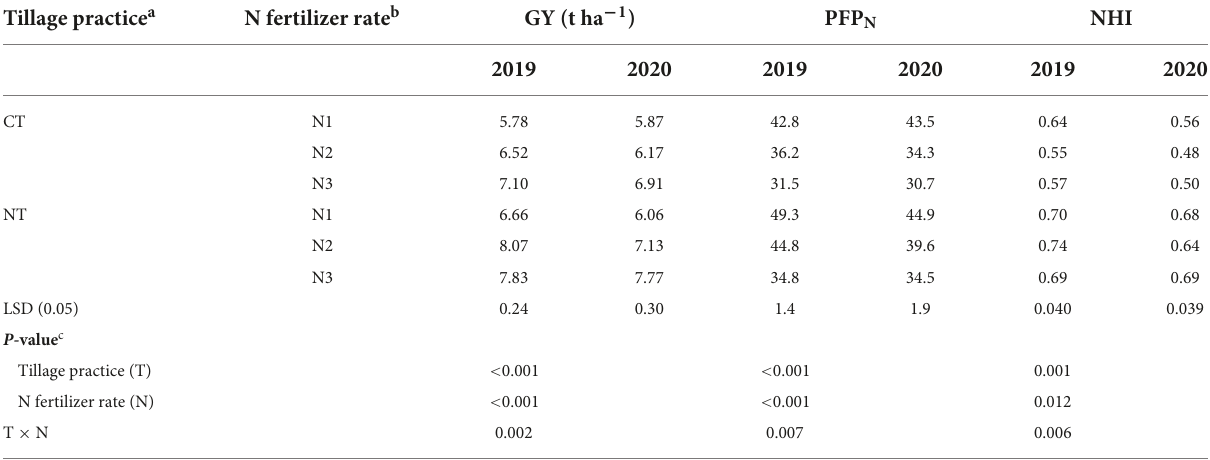
TABLE 5 The grain yield (GY), N partial factor productivity (PFP N ), and N harvest index (NHI) of spring wheat as affected by tillage and N fertilization treatments in 2019 and